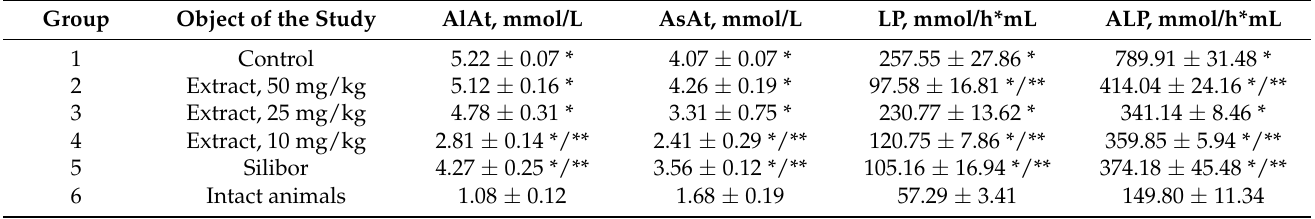
Table 6. The results of the study of the hepatoprotective activity of herb extract of A. eupatoria